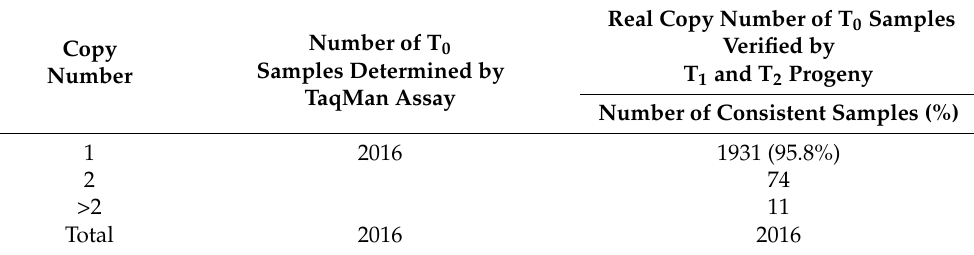
Table 5. Real copy numbers of 2016 T 0 samples with one technical repetition, verified by results of T 1 and T 2